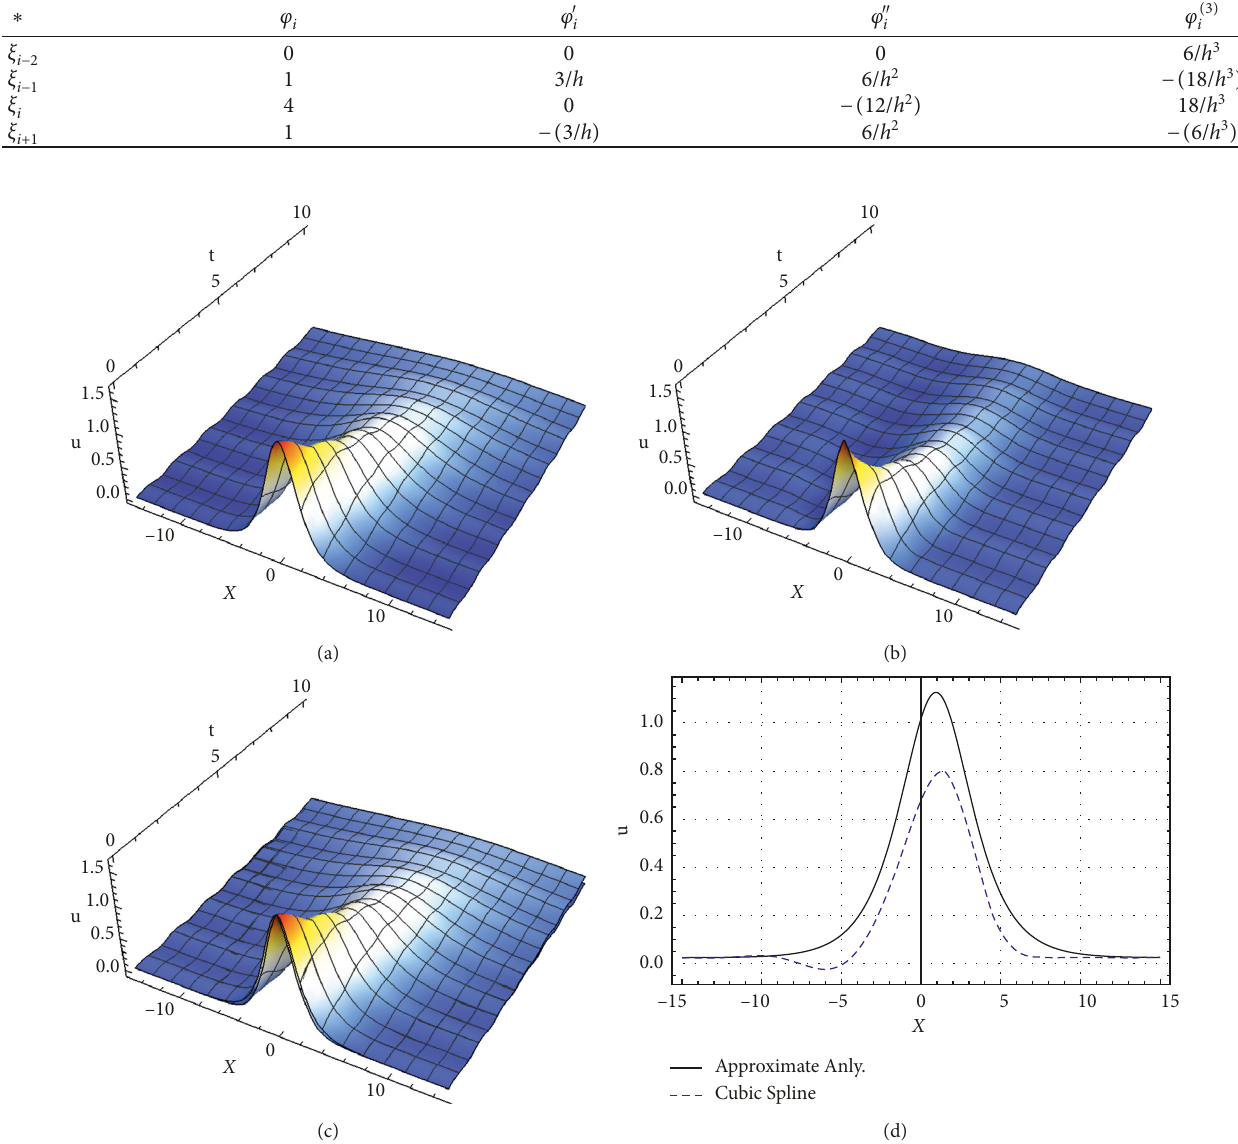
Figure 1: Profile of the approximate analytic soliton solution and the cubic B-splines soliton solution to the forced damped Gardner equation (2) is